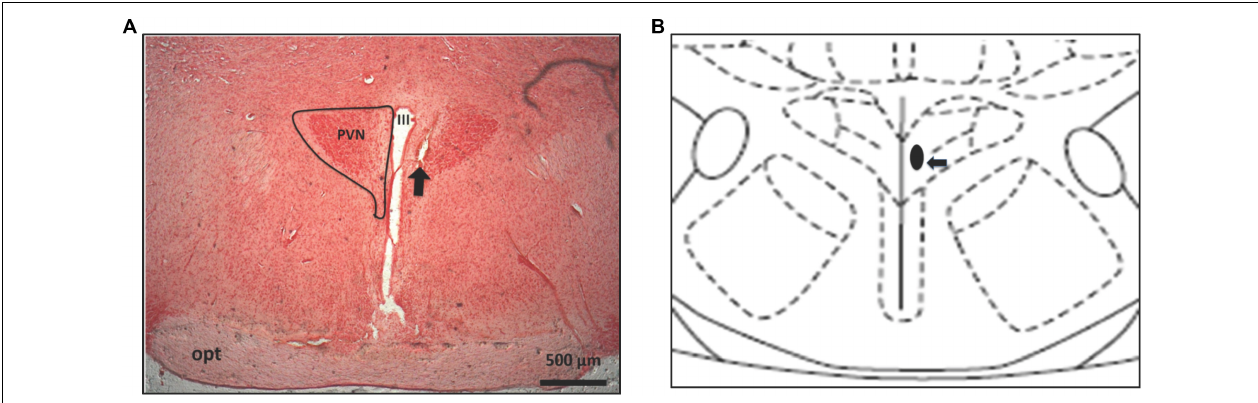
FIGURE 1 | Frontal section of the rat brain (40 µ m) (A) and schematic representation showing the center of injection into PVN (B) . The arrow indicates a microinjection site in PVN. PVN, paraventricular hypothalamus; III, third ventricle; OPT, optic tract.